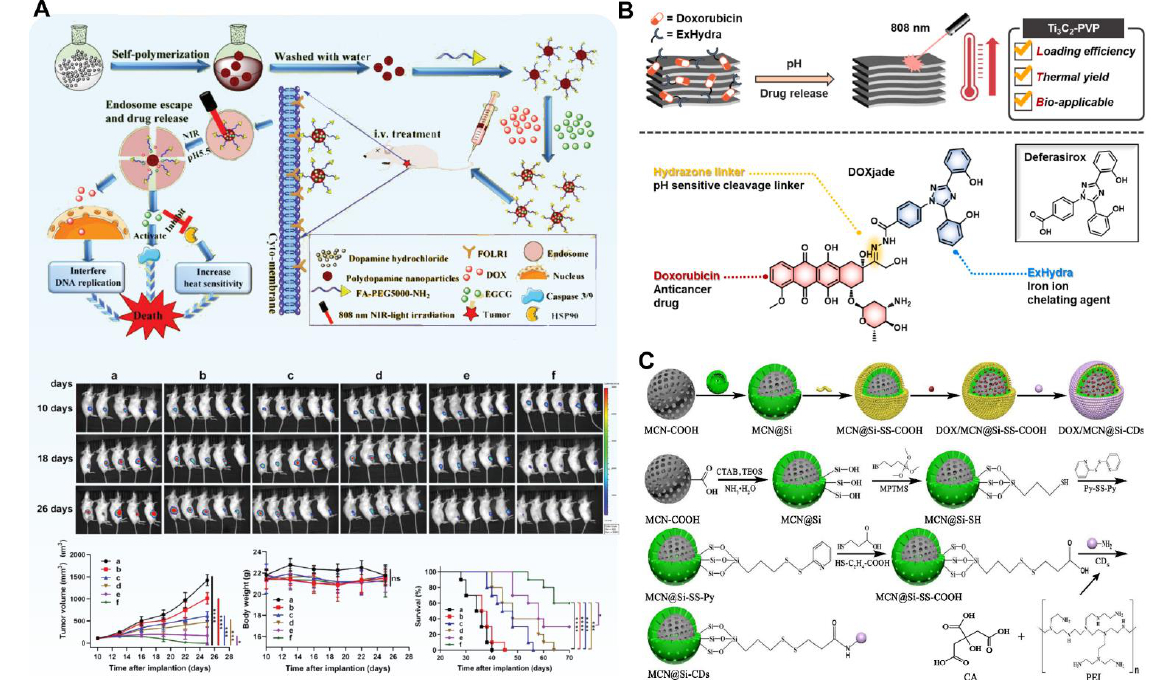
Figure 6. ( A ) Schematic illustrating the formation of the DOX-EGCG/PDA-FA NPs [133]. The representative tumor growth was shown in vivo by bioluminescence imaging at 10, 18, and 26 days after implantation. Changes in tumor volume, body weight and survival curves of mice given different treatments. ( a ) Normal saline (control), ( b ) free DOX, ( c ) DOX/DPA NPs+laser, ( d ) DOX- EGCG/DPA NPs+laser, ( e ) DOX/DPA-FA NPs+laser, ( f ) DOX-EGCG/DPA-FA NPs+laser. * p < 0.05, *** p < 0.001, and **** p < 0.0001 compared to f (n = 10) ( B ) Schematic representation of DOX jade